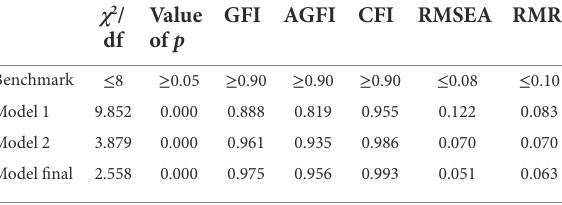
TABLE 2 Goodness of fit of the ELB scale with measurement models.